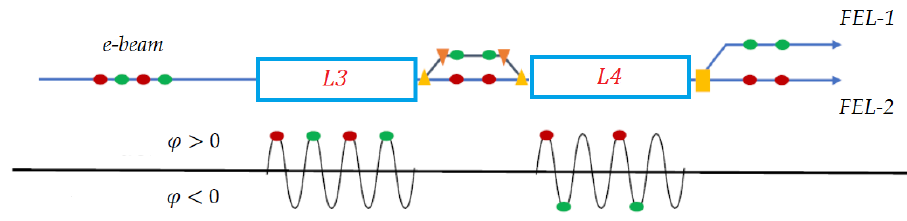
Figure 8. Sketch of multi-beam energy device proposed at SHINE ( ϕ ≡ accelerating